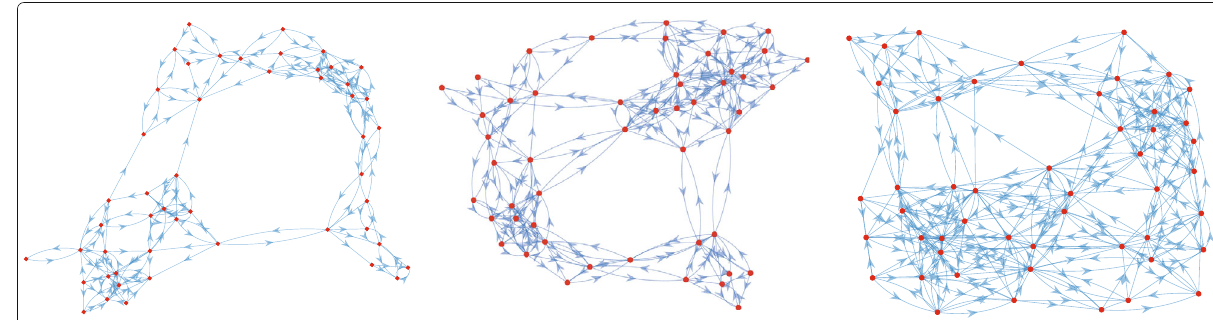
Fig. 3 Directed graphs with n = 50 nodes and increasing sparsity: G 1 , G 2 , and G 3